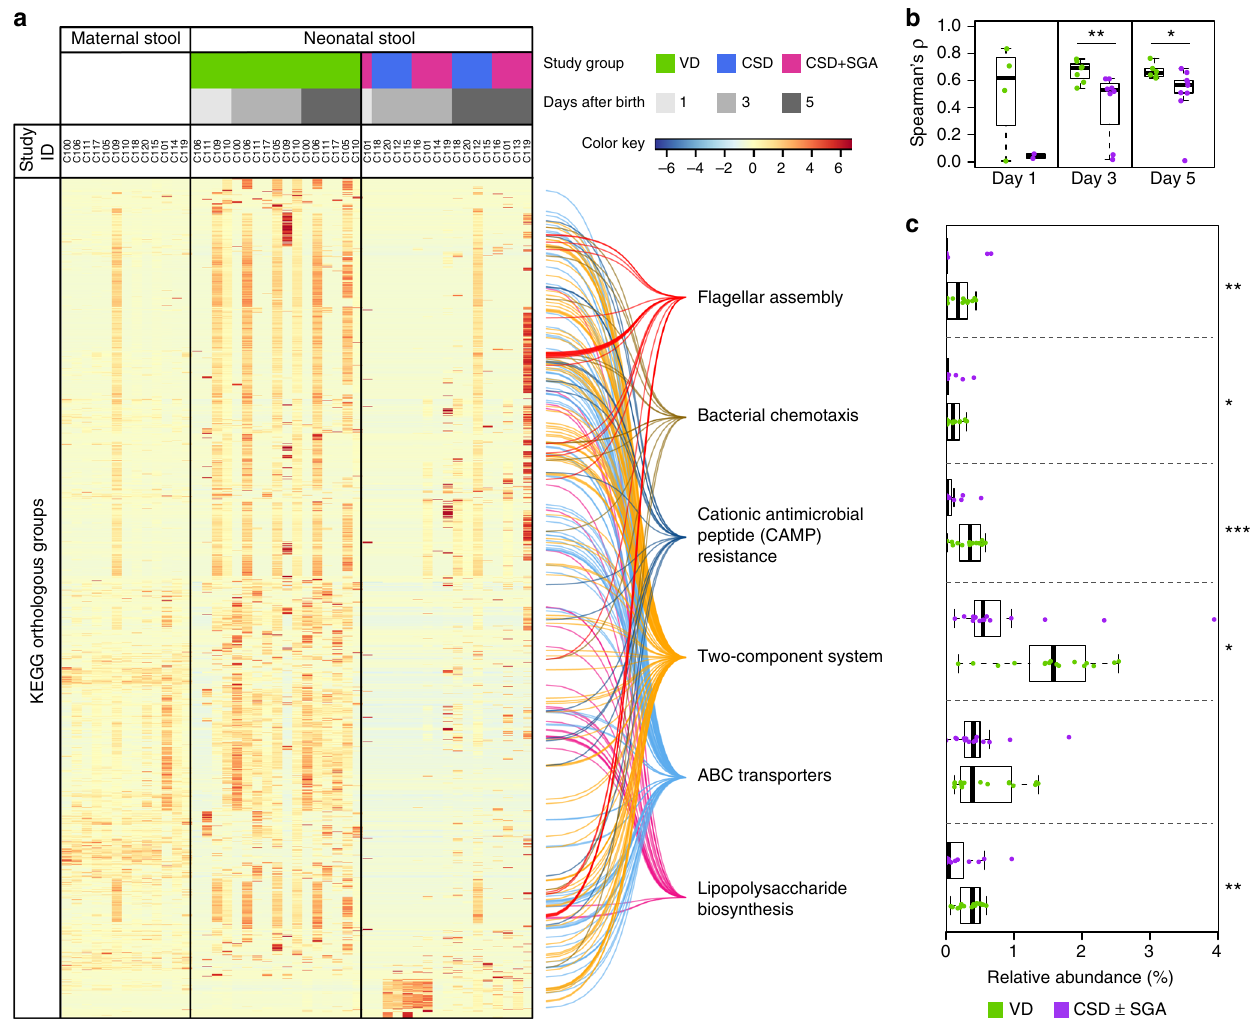
Fig. 2 Maternal and neonatal gut microbiome functional pro fi les. a Heatmap of relative abundance of gut microbial orthologous gene groups with signi fi cant differential abundances in neonates born by vaginal delivery (VD) compared to either caesarean section delivery (CSD) or CSD with small for gestational age (SGA) status (CSD + SGA) groups and having the same direction of log 2 fold change (calculated with the R package DESeq2 33 ; false-discovery-rate (FDR)-adjusted P < 0.05). Colour key indicates row-wise z-scores. The six signi fi cantly enriched pathways are indicated (FDR-adjusted P < 0.05). b Spearman correlation coef fi cients of functional pro fi les of neonatal and maternal gut microbiomes in VD and CSD (±SGA) neonates. c Cumulative relative abundance of enriched pathways indicated in a for VD and CSD (±SGA) groups. b , c Comparison by Wilcoxon rank-sum test for two-group comparisons with multiple testing adjustment; *FDR-adjusted P < 0.05, **FDR-adjusted P < 0.01, ***FDR-adjusted P < 0.001; Boxplots: centre line – median, bounds – fi rst and third quartile, whiskers < = 1.5 × interquartile